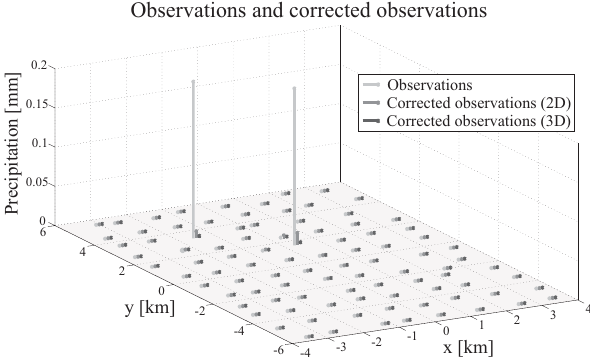
Fig. 11. Illustration of the station positions and observed 10 minutes precipitation values on 20 June 2007, 23:20UTC, collected during the field campaign COPS (light gray bars). Note the two readings of 0.2mm which are very likely due to erroneous random tipping or due to read out of memory, because no precipitation was observed at this time. The medium gray bars symbolize the observations cor- rected by a two dimensional ( x , y ) VERA-QC without gross error recognition, and the dark gray bars stand for those corrected by a three dimensional ( x , y , t ) VERA-QC without gross error recog- nition taking into account all measurements between 18:00 and 24:00UTC.